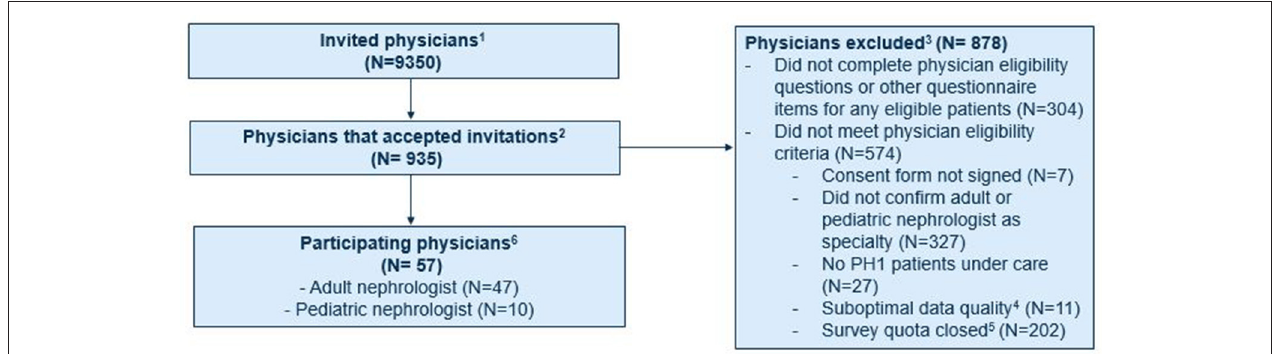
FIGURE 1 | Recruitment of physicians participating in chart review study. 1 Adult and pediatric nephrologists who were part of the Schlesinger Group healthcare and partner panels who were notified of the opportunity to participate in this study. 2 Physicians who accepted the invitation and were asked to complete screening questions to determine their eligibility to participate in the study. 3 Physicians who did not complete the eligibility criteria, did not provide data for any eligible patients, and did not meet the study eligibility criteria. 4 Included providers who selected responses that were illogical (e.g., reported number of patients under their care was larger than possible based on responses to initial screening questions) and were thus excluded from the study. 5 Includes providers who accepted invitation after quotas for their respective country and/or specialty (as implemented during physician recruitment to ensure representation of patients from different countries and age groups) had been met. 6 Physicians who met the study eligibility criteria and provided information on 120 eligible patients with